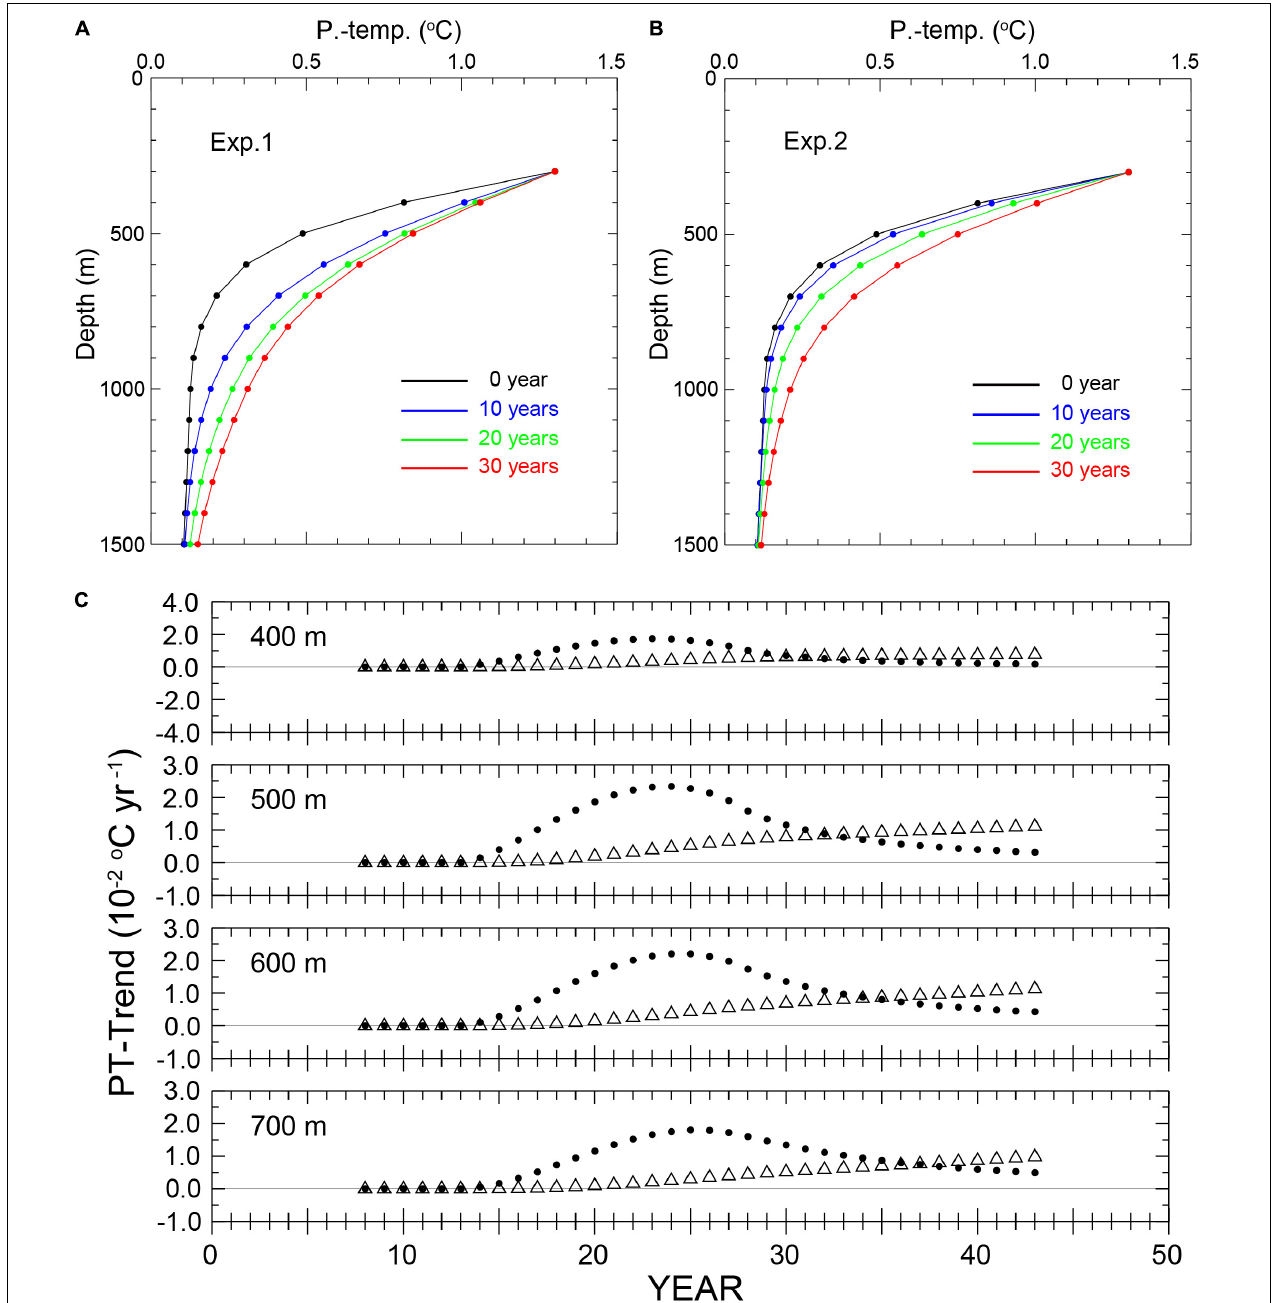
FIGURE 11 | Decadal evolution of the model-calculated PT profiles after the reduction of the cold water injection: (A) Exp. 1 and (B) Exp. 2. For a comparison with the observed PT distributions ( Figure 9 ), only the PT profiles above 1500 m are shown. The profile at 0 year (black) indicates the equilibrium profile at S 0 = 7.9 × 10 − 7 m s − 1 (25 m year − 1 ) and K = 2.0 × 10 − 4 m 2 s − 1 at 600 years in the equilibrium calculation. Time series of the model-calculated PT changing rates evaluated with the 15-year sliding window are shown in (C) by solid circles (Exp. 1) and empty triangles (Exp. 2). The evaluations were performed for the 50-year long datasets that consist of the last 20 years of the equilibrium calculation (581–600 years) and the results from Exps. 1 and 2 of 30-year